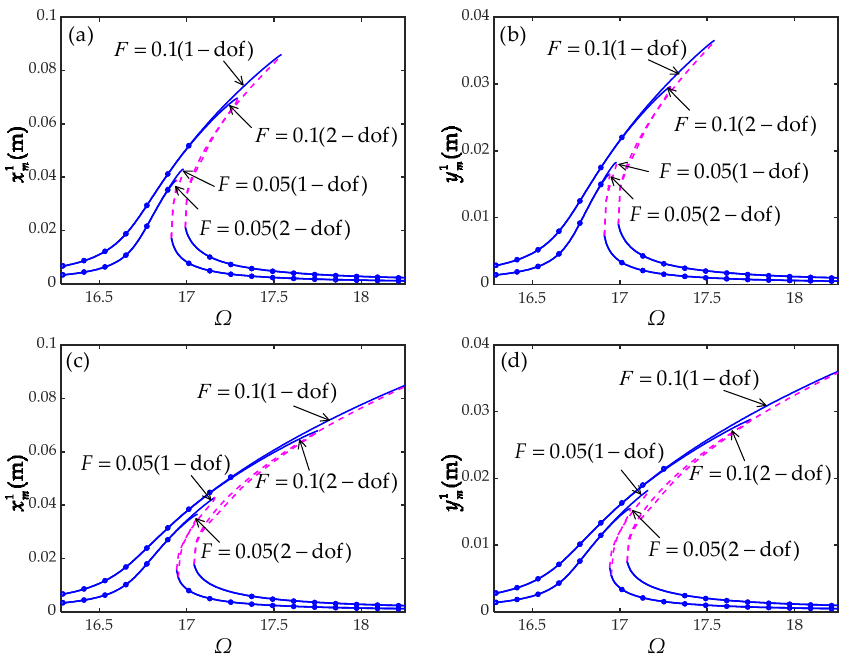
Figure 8. Frequency response curves for the first mode at Ω = ω 1 + εσ 2 and σ 1 = 0.01: ( a , b ) k N = 1.2 × 10 4 N · m/rad 3 ; ( c , d ) k N = 2.4 × 10 4 N · m/rad 3